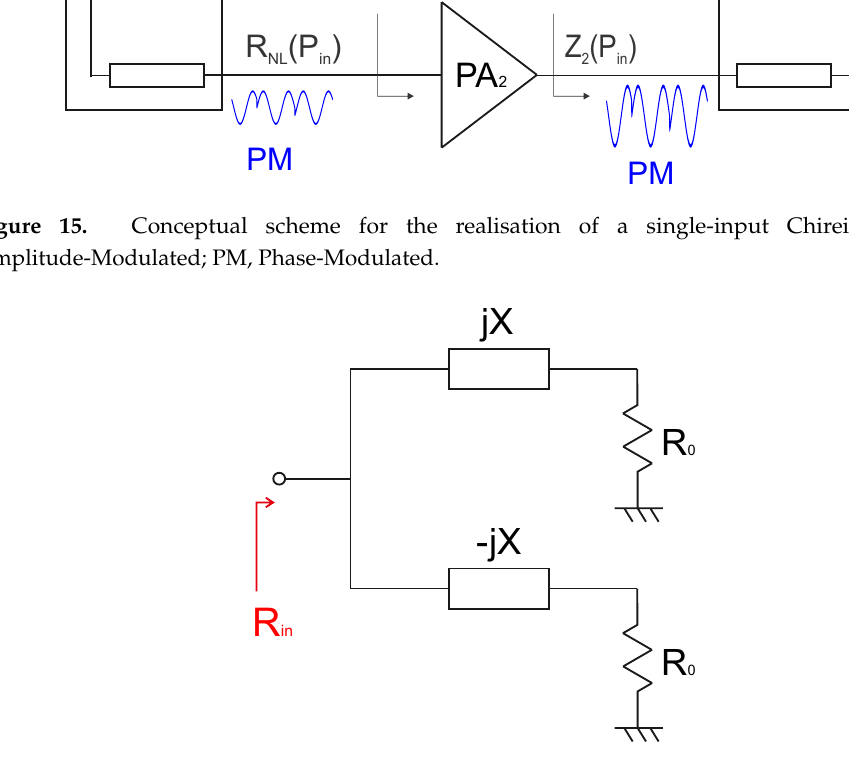
Figure 16. Resistance compression network: R in varies as a function of R 0 over a range, set by X , that is only a fraction of the range of variation of R 0